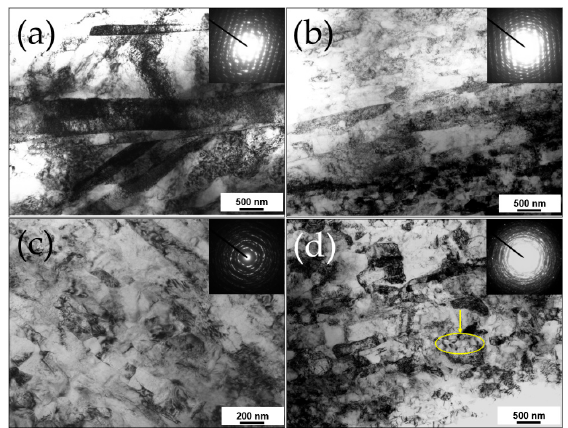
Figure 5. TEM micrographs and selected area diffraction (SAED) patterns of the rolled Ti at various SRs of ( a ) one, ( b ) three, ( c ) four and ( d ) five [ 41 ]. Reproduced with permission from Kim et al., Scr. Mater. ; published by Elsevier, 2011.